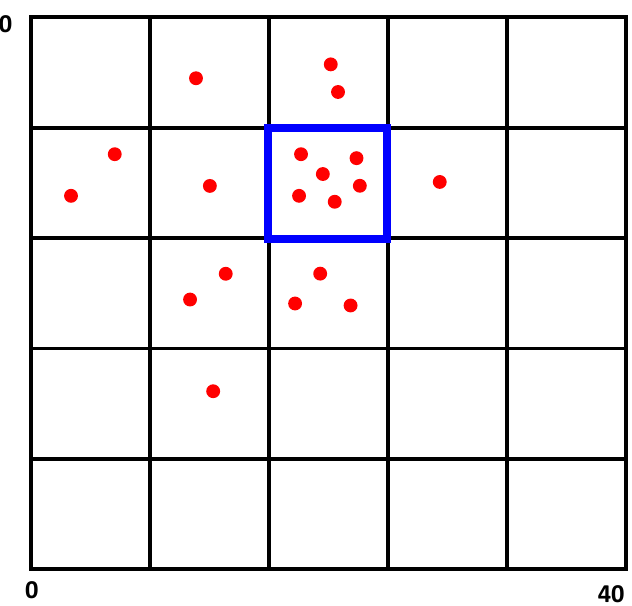
Figure 9. The OD_CTRD process: A 40 m × 40 m network region broken into 5 × 5 grids. The red dots represent the mapped trilateration results, while the blue box shows the grid with the highest number of mapped location estimates. The centroid of the grid box is assumed to be the final location of the